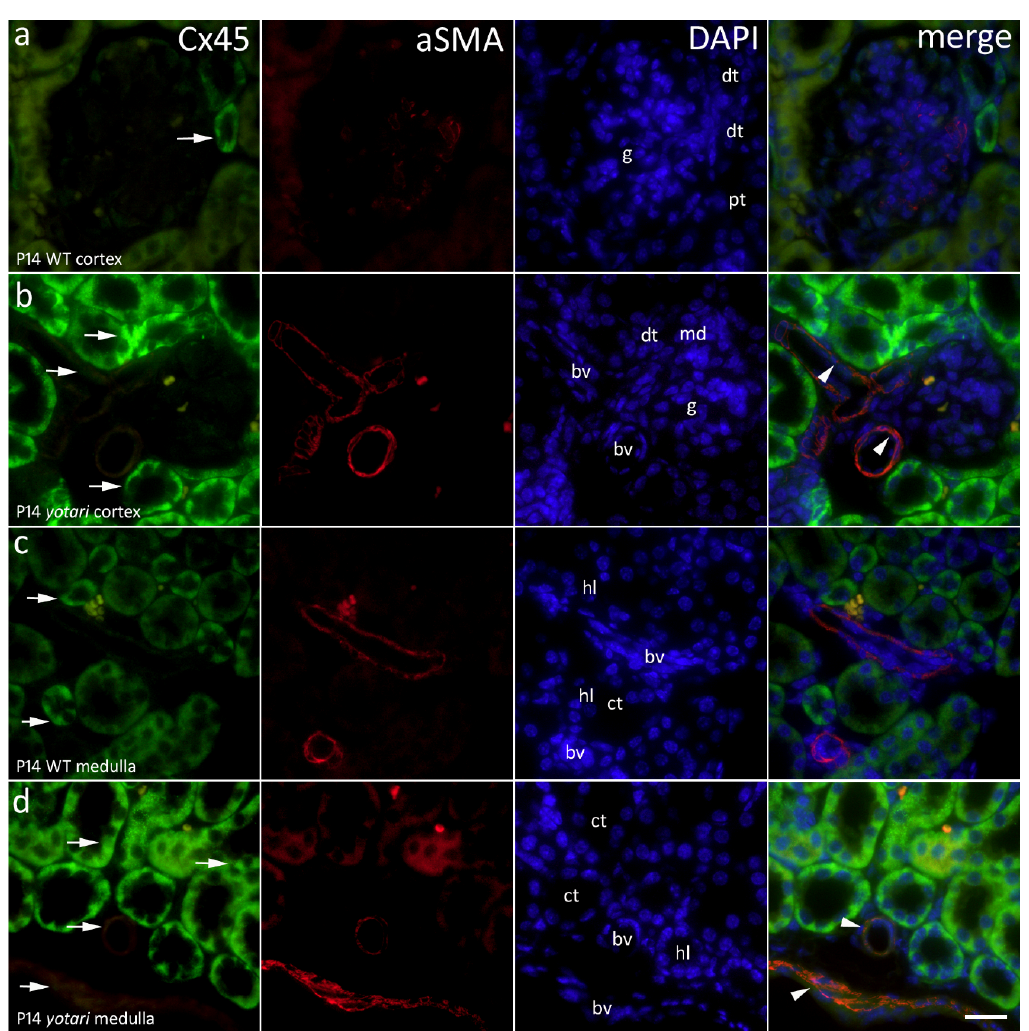
Figure 5. Immunofluorescence staining of postnatal yotari ( b , d ) and wild type ( a , c ) mouse kidneys with the Cx45 marker and co-expression of Cx45 and aSMA with DAPI nuclear staining. Expression of Cx45 (arrows), collecting tubules (ct), blood vessels (bv), macula densa (md), glomeruli (g), loop of henle (hl), proximal convoluted (pt), and distal convoluted tubules (dt). Co-expression of Cx45 and aSMA (arrowheads) can be seen on merged photographs. Autofluorescence of nephron tubules and erythrocytes (*), not to be mistaken with positive immunofluorescence staining. Scale bar is 20 μ m, refers to all images.